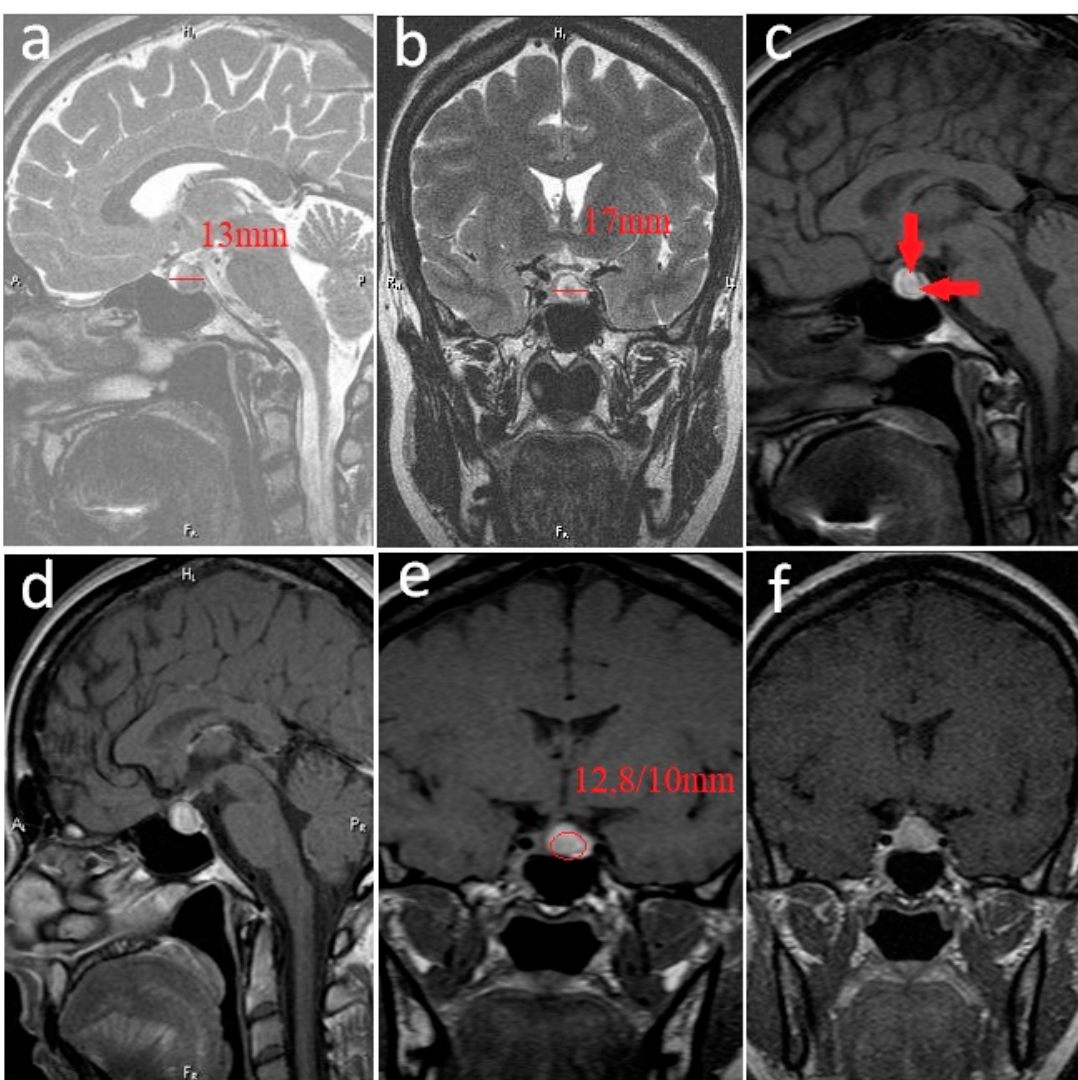
Figure 1. Prolactinoma with bleeding areas inside. Pituitary MRI at diagnosis. ( a ). Noncontrast sagittal T2-weighted image. ( b ). Noncontrast coronal T2-weighted image. ( c ). Noncontrast sagittal T1-weighted image—diffuse bleeding (hyper T1—arrows). ( d ). Postcontrast sagittal T1-weighted image. ( e ). Postcontrast coronal T1-weighted image. ( f ). Postcontrast coronal T1-weighted image. Pituitary fossa—anteroposterior diameter: 13 mm; transverse diameter: 17 mm; oval-shaped lesion 12.8/10 mm; heterogeneous high-signal T2-weighted ( a , b ); T1-weighted ( c , d ), located in the ade- nohypophysis with high signal in T1; weighted areas corresponding to the subacute intratumoral hemorrhage due to the presence of methemoglobin, heterogeneous enhancement ( e , f ),